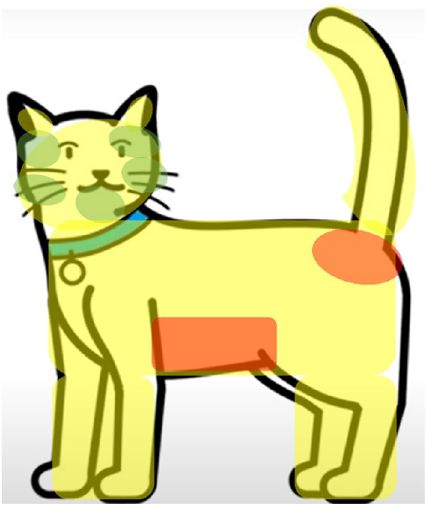
Figure 2. Image depicting the areas coded as ‘Green’ (the base of ears, cheeks and/or under bottom jaw), ‘Red’ (the stomach and base of the tail) and ‘Yellow’ (all other areas), see ethogram in Supplementary File S2 for further